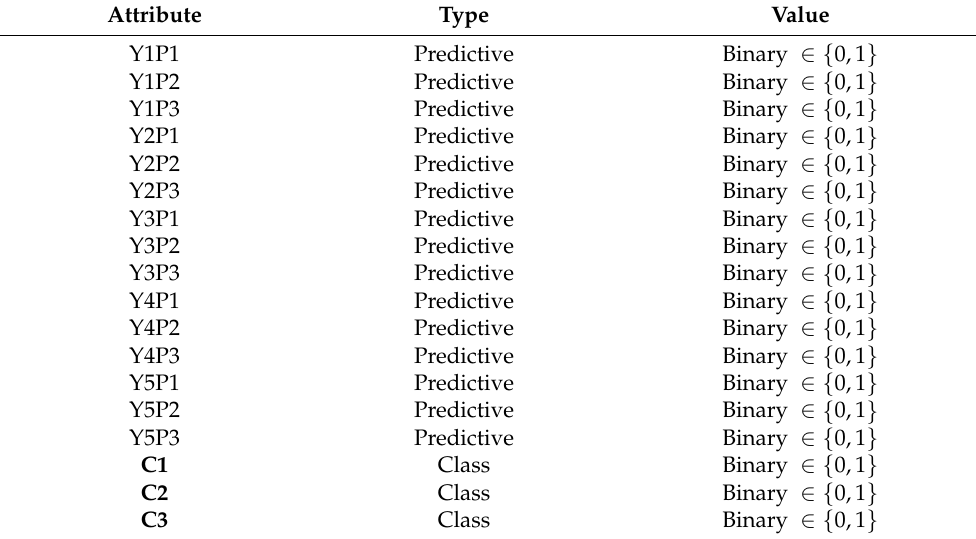
Table 1. Adopted Dataset